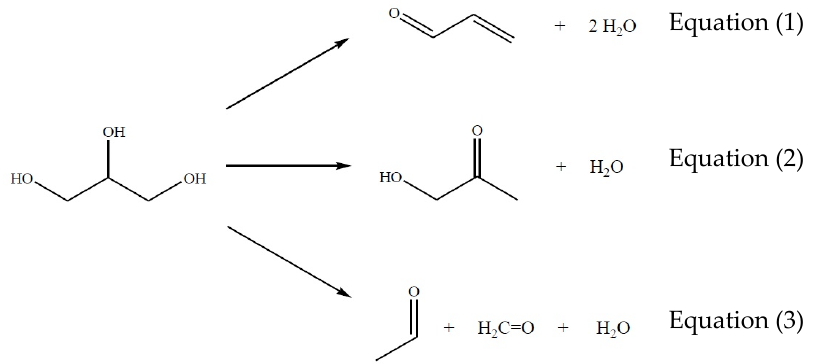
Figure 2. Main reactions from glycerol to obtain acrolein, acetol, ethanal, and methanal.